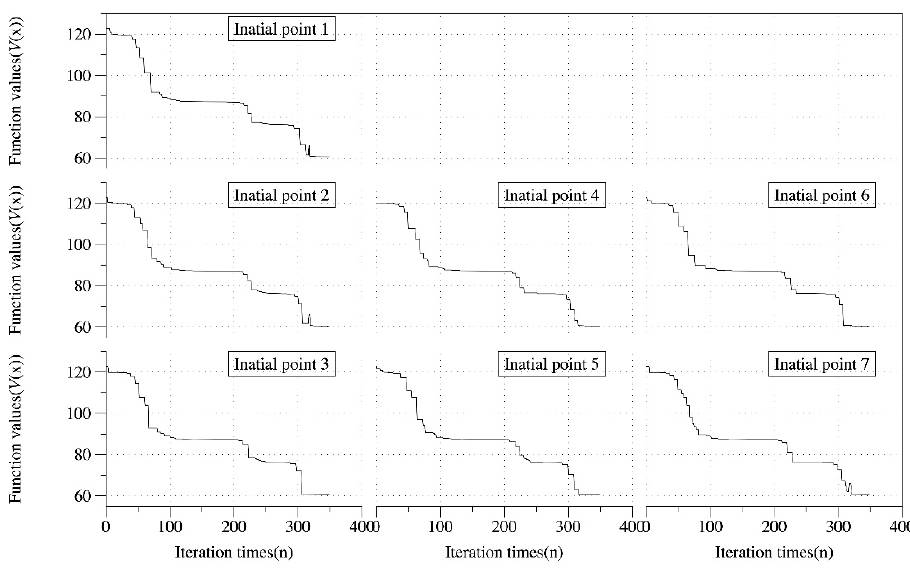
=0.96 =0.04 w w ， and Thres = 0.001. scl m